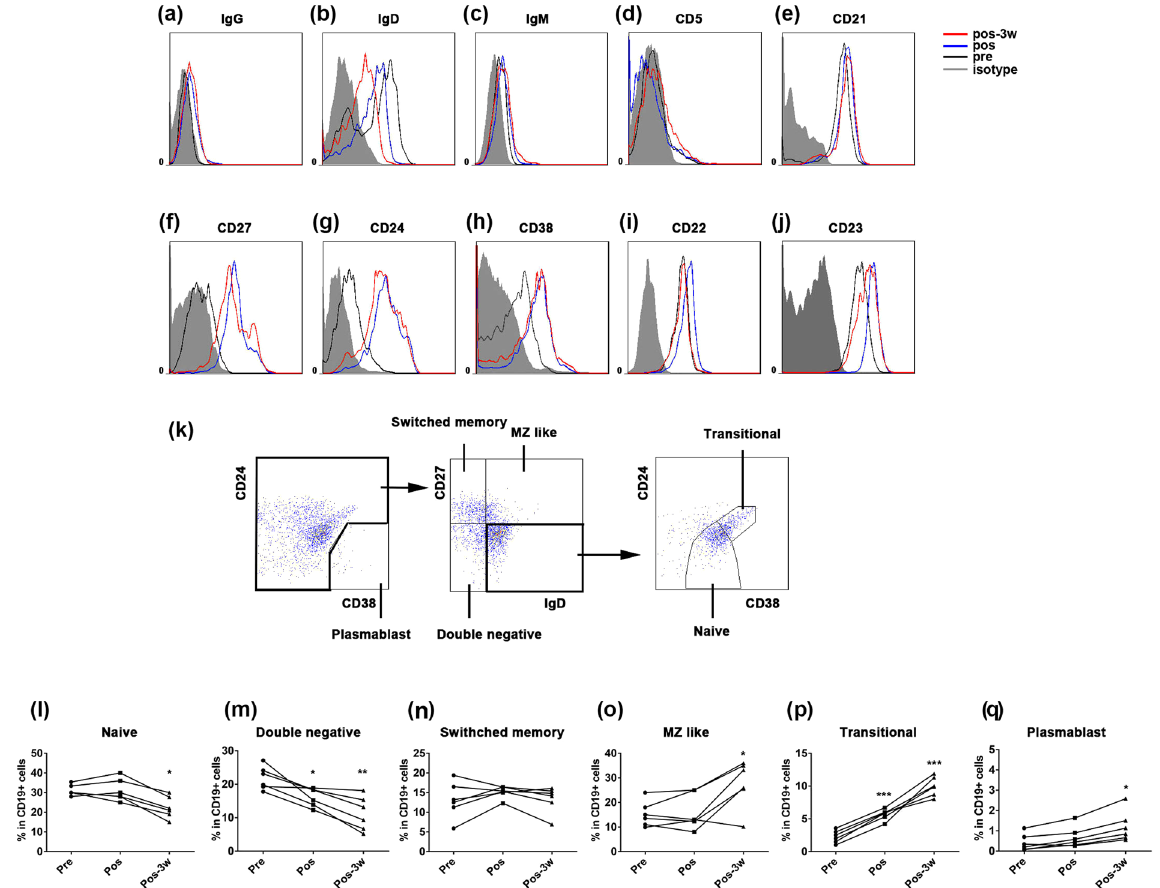
Figure 4. Phenotypes and subpopulation analysis of peripheral B cells after HSRT. ( a – j ) The phenotypes of peripheral CD20 + B cells are shown before and after treatment with HSRT. Filled grey indicates the isotype, unfilled black indicates pretreatment, unfilled blue indicates post-treatment, and unfilled red indicates 3 weeks post-treatment. ( k ) The gating strategy that was used to identify human B-cell subsets. ( l – p ) The percentages of cells that were naïve B cells ( l ), double-negative B cells ( m ), switched-memory B cells ( n ), MZ-like B cells ( o ), transitional B cells ( p ), and plasmablasts ( q ) in CD20 + B cells were analyzed at the indicated timepoints before and after HSRT. Dark circles indicate pretreatment, dark squares indicate post-treatment, and dark triangles indicate 3 weeks post-treatment. All statistical analyses were performed versus Pre(pretreatment) using ANOVA with Bonferroni’s post-test. * p < 0.0167, ** p < 0.01; *** p <